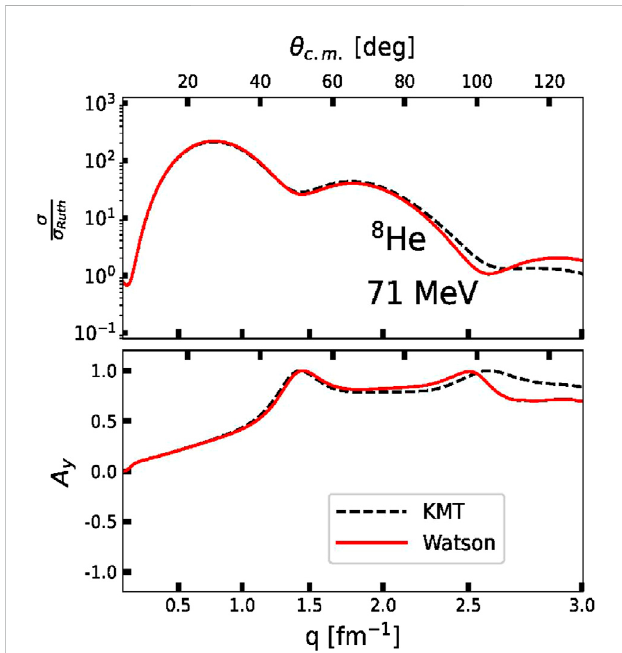
FIGURE 1 The angular distribution of the differential cross section divided by the Rutherford cross section (upper panel) and the analyzing power ( A y ) for elastic proton scattering from 8 He at 71 MeV laboratory kinetic energy as function of the momentum transfer q and the c. m. angle calculated with the LENPIC SCS chiral interaction [19] with a cutoff R = 1 fm. The calculations are based on non-local densities using Z Ω = 14 MeV at N max = 14. The solid (red) line stands for using the Watson optical potential while the black (dashed) line represents the KMT